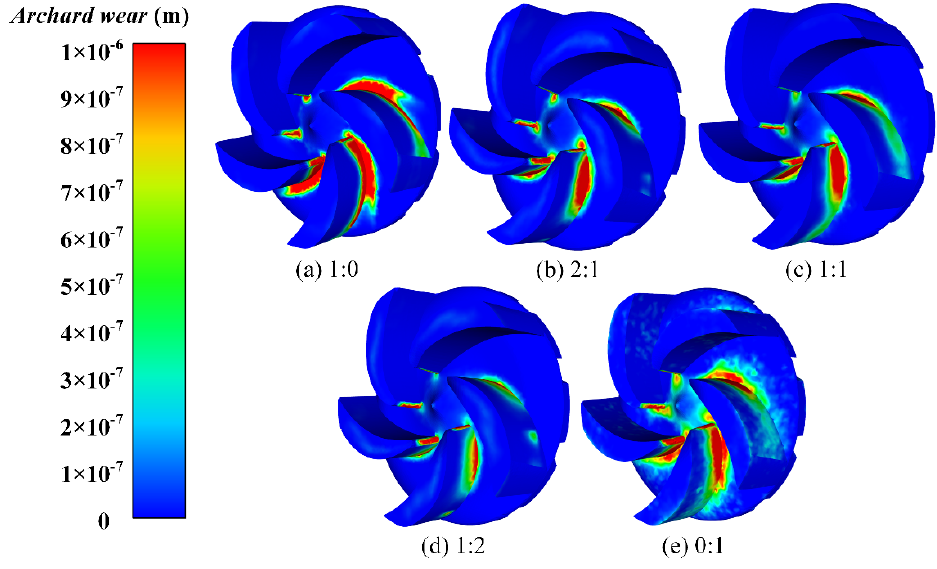
Figure 13. Impeller wear distribution under different particle ratio.